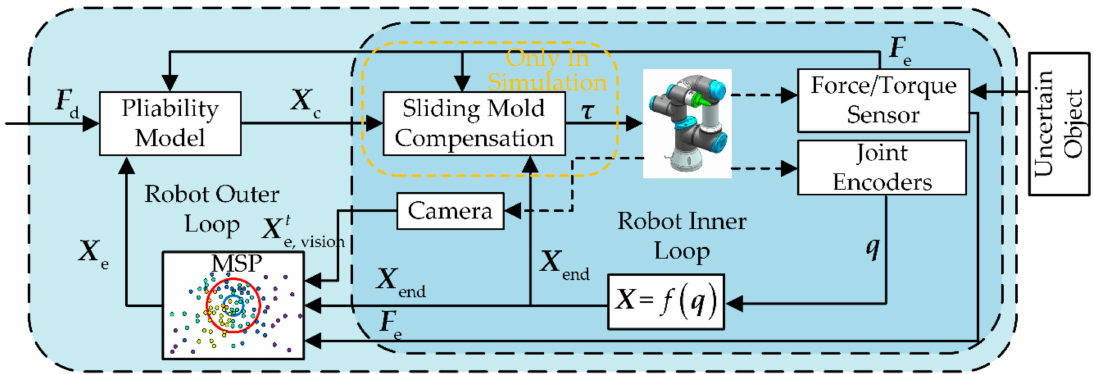
Figure 8. Control system designed with